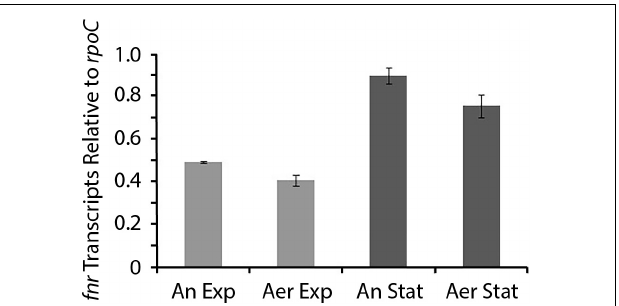
FIGURE 4 | Level of fnr AF transcripts in aerobic and anaerobic conditions. RT-qPCR data are expressed as relative values normalized to the housekeeping gene rpoC and presented as the average of triplicate samples ± the standard deviation, two-way Anova p < 0.05 . An Exp, anaerobic exponential; Aer Exp, aerobic exponential; An Stat, anaerobic stationary; and Aer Stat, aerobic